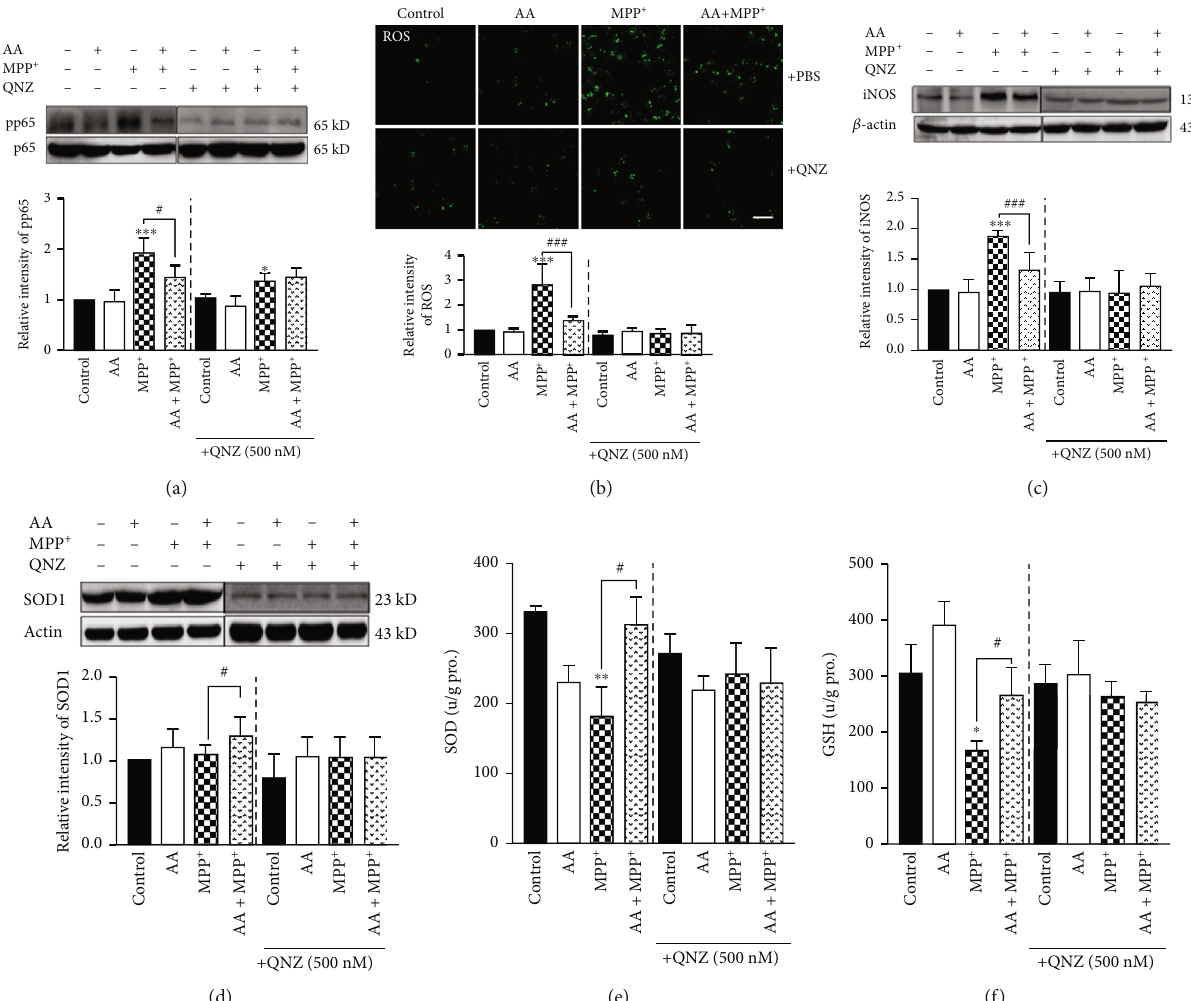
Figure 4: Inhibition of NF- κ B signaling blocks the antioxidative e ff ects of ascorbic acid and perpetuates cytotoxicity in MPP + -treated astrocytes in vitro . Primary astrocytes were copretreated with 1mM of AA and 0.5mM of QNZ (EVP4593) for 24h and/or 1 mM of MPP + for another 24 h. (a) The NF- κ B-inhibition e ffi ciency was detected by measuring the phosphorylation of p65 by Western blotting ( n = 3 ). (b) Intracellular ROS was measured using the carboxy-H2DCFDA method (scale bar, 100 μ m) ( n = 3 ). (c) The expression of iNOS was detected by Western blotting ( n = 3 ). (d) The expression of SOD1 was detected by Western blotting ( n = 3 ). (e) The concentration of SOD in the supernatant from primary astrocytes was detected by ELISAs ( n = 3 ). (f) The concentration of GSH in the supernatant from primary astrocytes was detected by ELISAs ( n = 3 ). Data were obtained from three independent experiments. One-way ANOVAs followed by LSD pairwise comparisons were performed. ∗ was considered signi fi cant compared to control ( ∗ P < 0 : 05 , ∗∗ P < 0 : 01 , and ∗∗∗ P < 0 : 001 ). # was considered signi fi cant compared to MPTP or MPP + ( # P < 0 : 05 , ## P < 0 : 01 , and ### P < 0 : 001